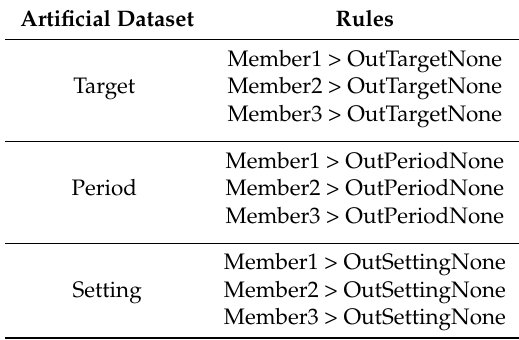
Table 4. OneR test.